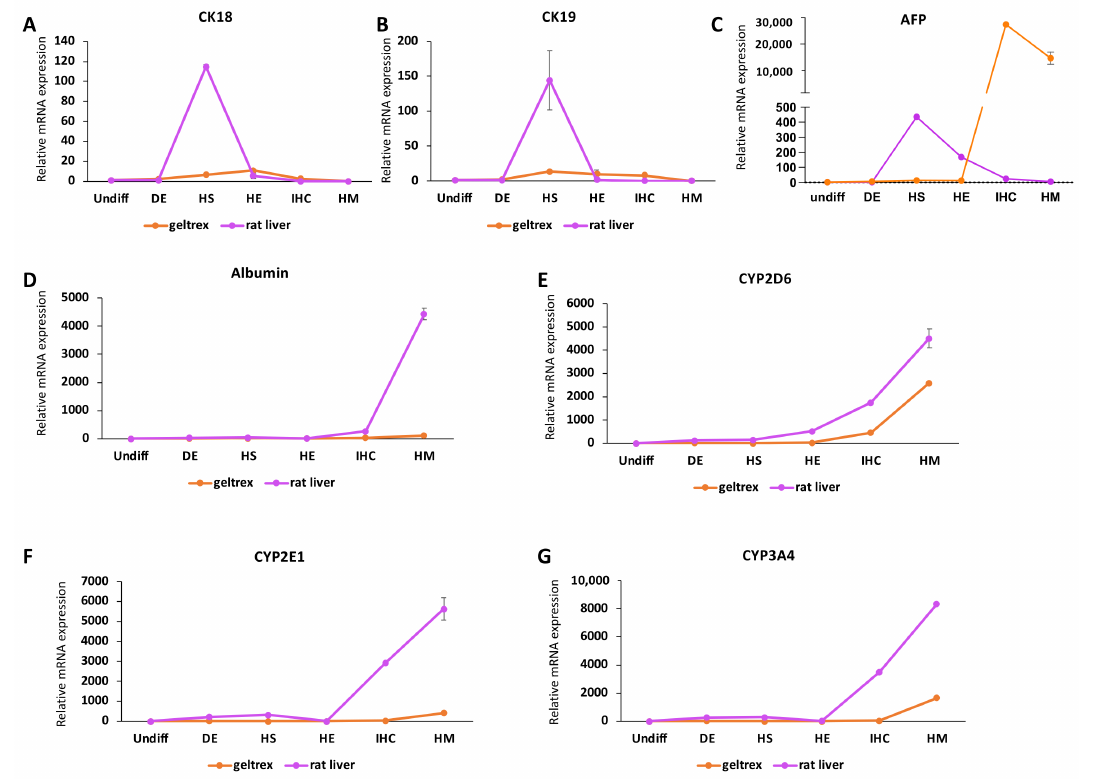
Figure 4. The changes in expression patterns of early and mature hepatic markers in iPSCs throughout differentiation in native liver ECM. qRT − PCR analysis results showing the mRNA expression levels of ( A ) CK18, ( B ) CK19, ( C ) AFP, ( D ) albumin, ( E ) CYP2D6, ( F ) CYP2E1, and ( G ) CYP3A4 relative to the respective expression levels in undifferentiated iPSCs throughout the differentiation in the geltrex and decellularized rat liver (rat liver) groups. For rat liver data, samples from three scaffolds at the DE, HS, HE, IHC, and IHC+ stages were analyzed. For geltrex data, at least three different differentiations at each stage were used in